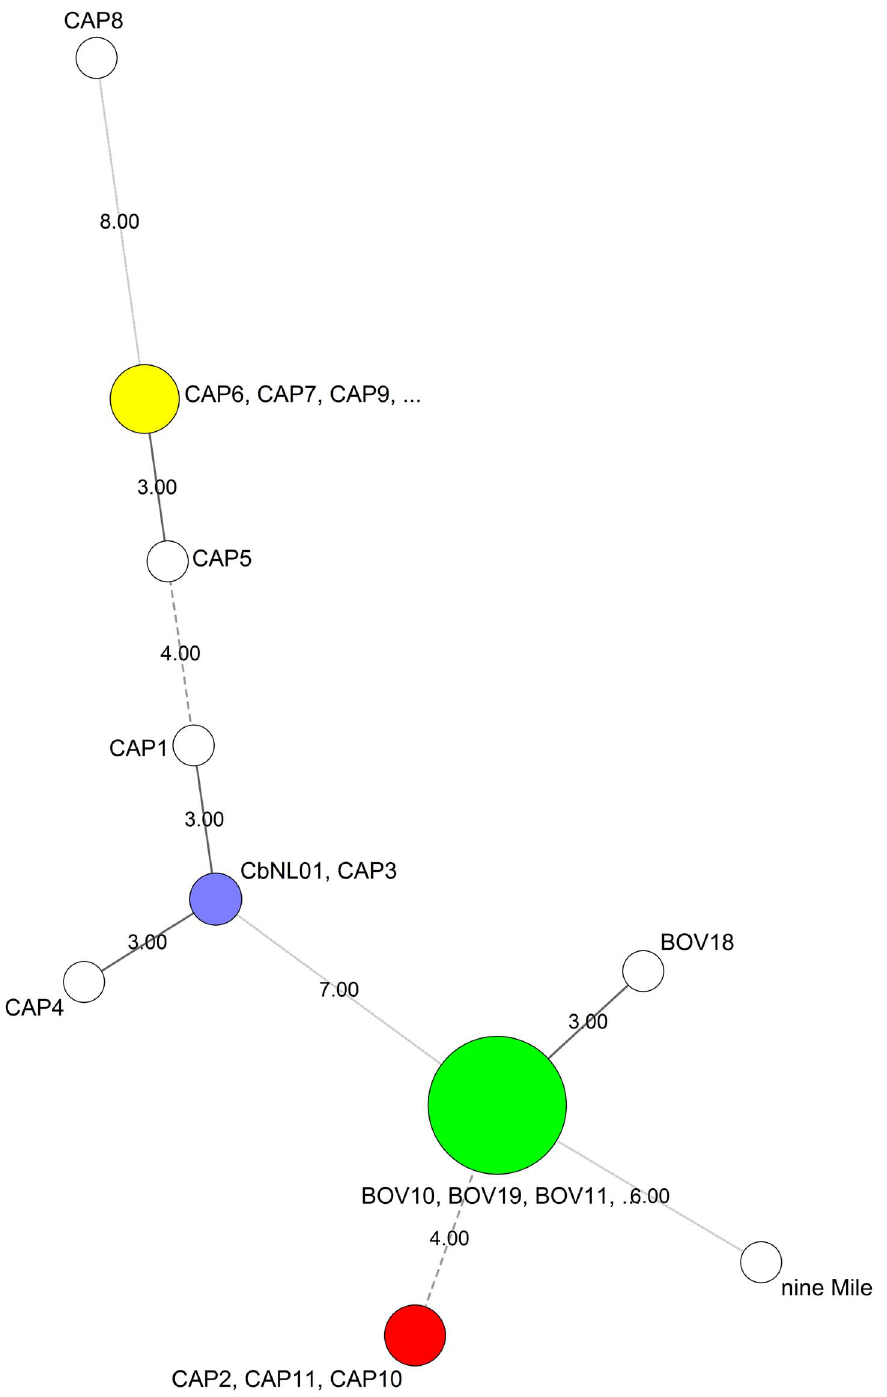
Figure 1. Minimum spanning tree analysis of MLVA profiles from Belgian livestock clinical samples positive for C.burnetii . 10-locus MLVA profiles were determined for 11 goat and 20 bovine positive samples collected between 2009 and 2011. Clustering by minimum spanning tree was performed with Bionumerics and included the Nine Mile reference strain and CbNL01 (MLVA profiles derived from publicly available data). Circles outline the genetic profiles of strains found in positive clinical samples. Numbers on the connecting lines refer to the number of markers differing between samples. The size of the circles is proportional to the number of strains bearing the same genetic profile. Most bovine strains (19/20) are closely related. One goat sample (CAP3) was infected with a strain displaying a genetic profile identical to that of CbNL01.